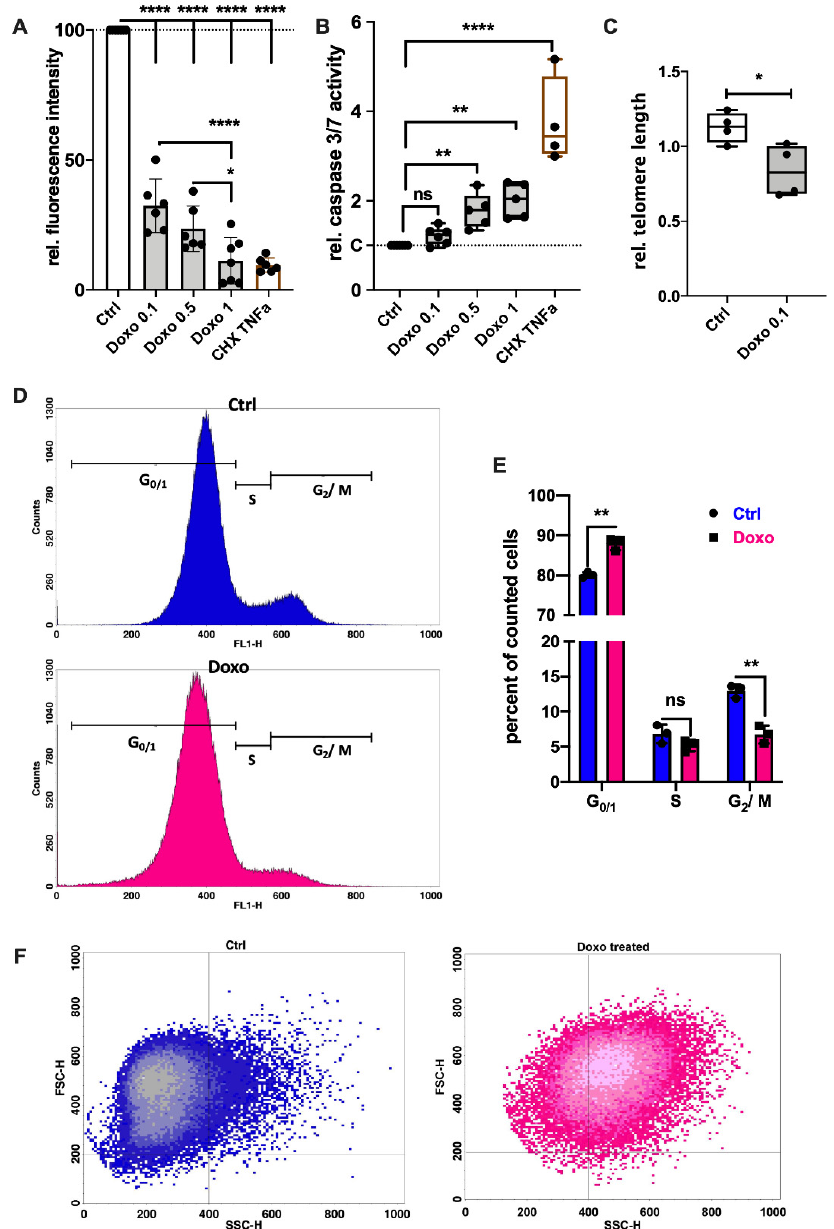
Figure 1. Influence of Doxo stimulation on the cell cycle and apoptosis of hAC. ( A ) Fluorescence intensity of the Alamar Blue assay after 7 d of Doxo-stimulation relative to the unstimulated control; TNFa + CHX served as the apoptosis control; n ≥ 6. ( B ) Relative caspase-3/7 activity after the addition of Doxo at different concentrations or TNF + CHX (apoptosis control); n ≥ 5. ( C ) Relative telomere length in untreated hAC compared to hAC treated with 0.1 μ M Doxo for 7 d. ( D ) Exemplary histogram of the flow cytometric cell cycle analysis; blue curve = untreated hAC at passage 2; pink curve = hAC at passage 2, treated with 0.1 µ M Doxo for 7 d. ( E ) Corresponding statistics of the cell cycle analysis; n = 3. ( F ) Exemplary dot plots of the cell size (FSC-H) vs. granularity (SSC-H) of unstimulated (blue) or Doxo-stimulated (pink) hAC, assessed by flow cytometry. Data are presented as scatter plot with bars, mean with standard deviation; or box plots with median, whiskers min to max. Significant differences between groups are depicted as: **** p ≤ 0.0001; ** p ≤ 0.01; * p ≤ 0.05. Statistical analysis: ( A , B ) one-way ANOVA, Sidak’s multiple comparisons test; ( C ) paired t -test; ( D ) multiple t -test. Ctrl = control (unstimulated cells), Doxo = doxorubicin, rel. = relative, ns = not